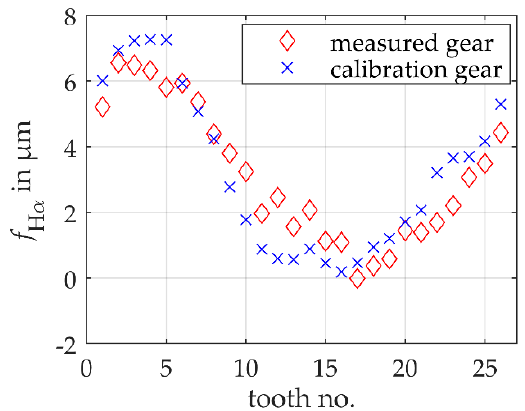
Figure 3. Profile slope deviations f H α of the individual teeth of the gear to be measured and the calibration gear measured with a coordinate measuring machine.